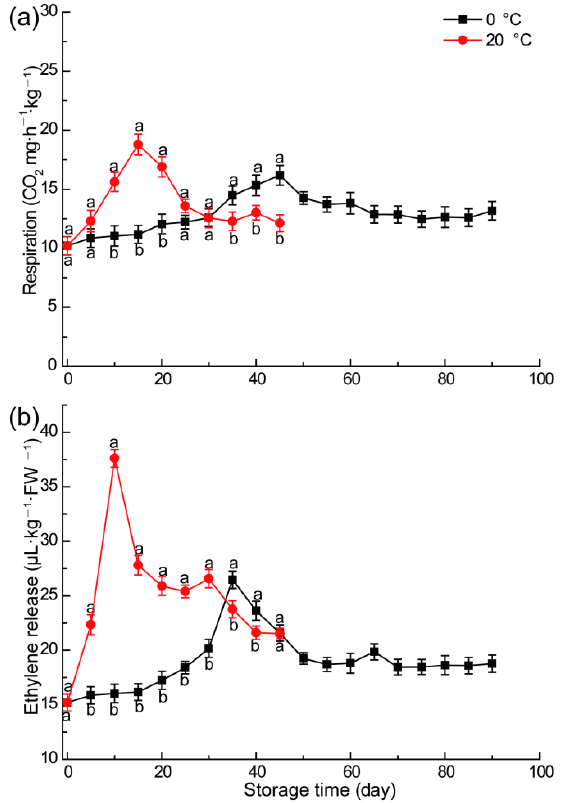
Figure 2. Respiration rates ( a ) and ethylene release ( b ) of apple fruit under different temperature and time. Vertical bars indicate ± standard errors of the mean values ( n = 5). Different letters represent significant differences among different treatment for each sampling time at p < 0.05.